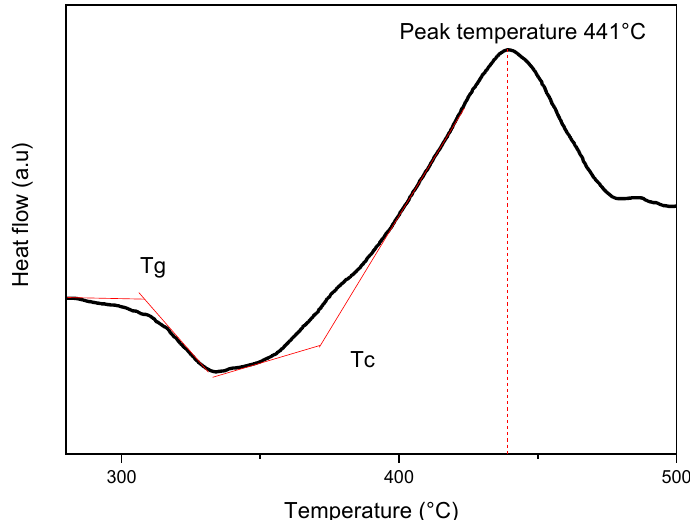
Figure 8. DSC curve of the Ta-free TFMG containing 36 at % of Cu and 64 at % of Zr. Tg: glass transition temperature; Tc: crystallization temperature.